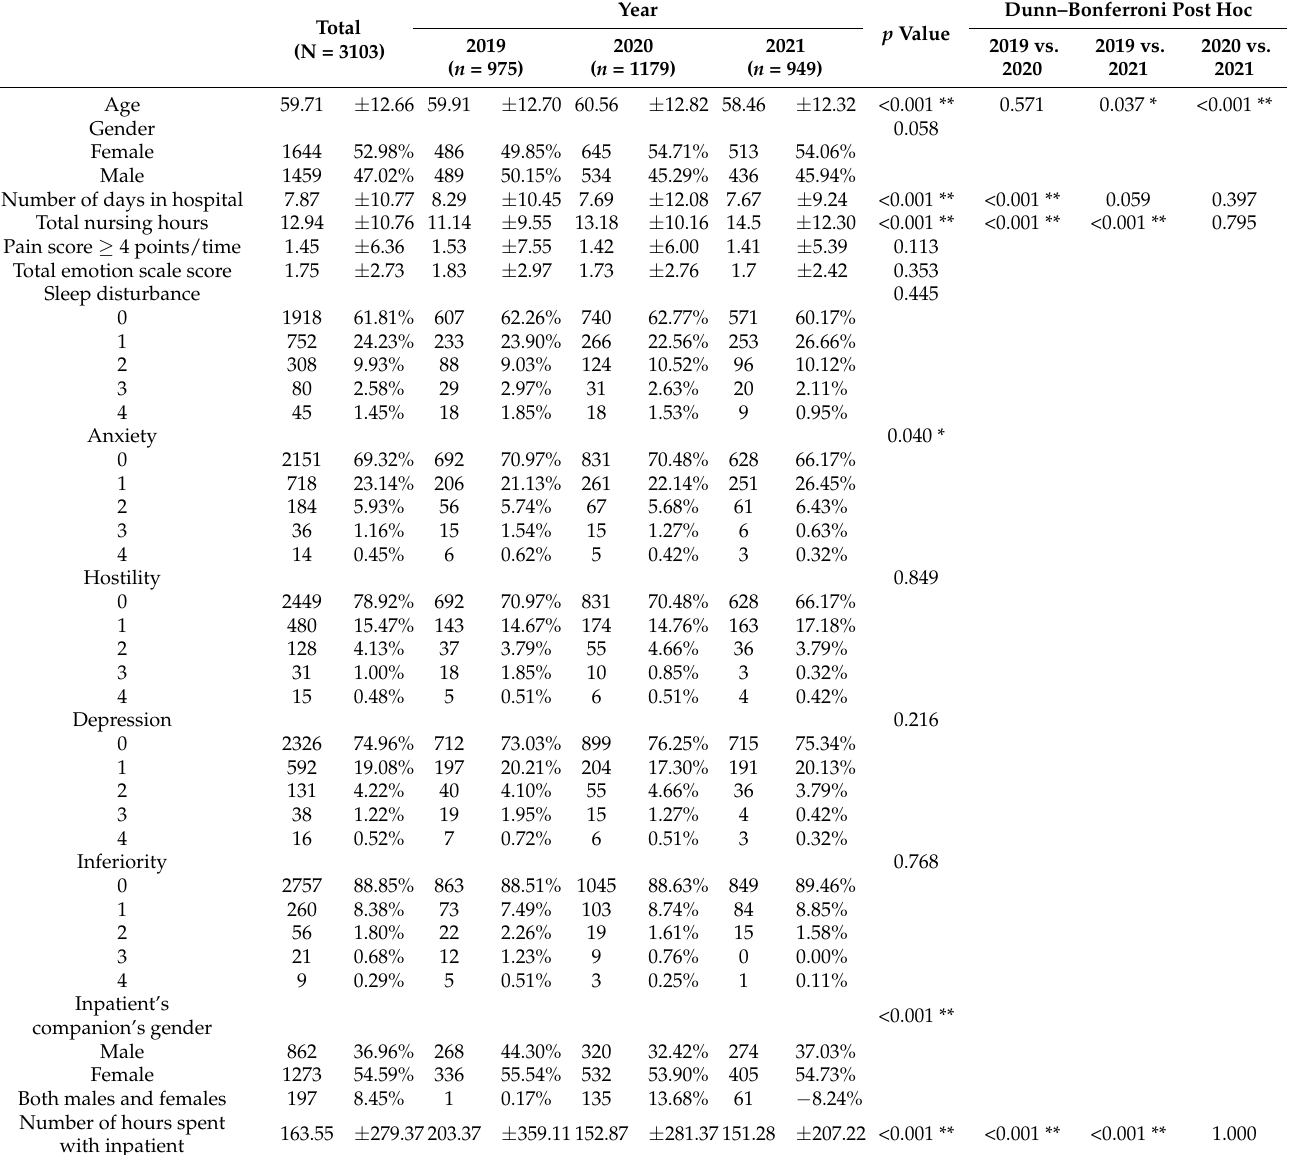
Table 1. Basic statistics of cancer inpatients (N = 3103) and inpatient companions (N =